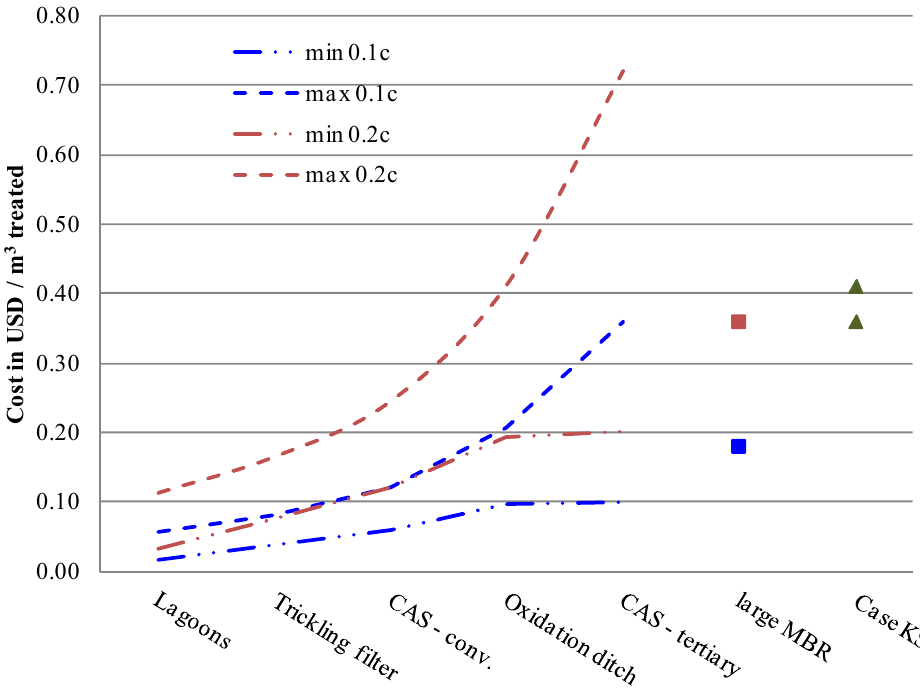
Figure 5. Estimated cost/m 3 for wastewater treatment using different